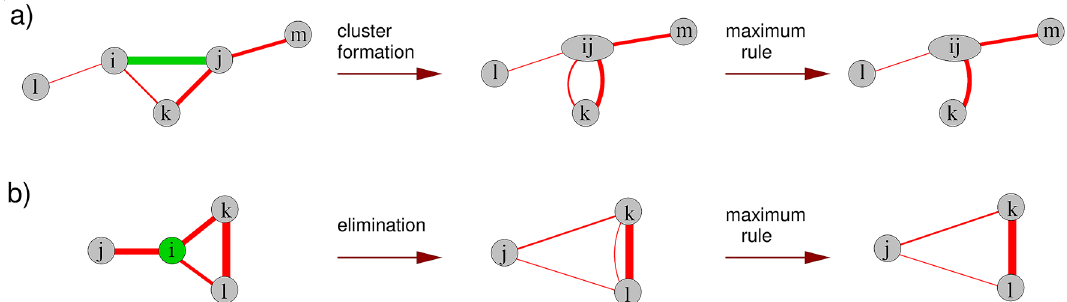
Figure 2. Illustration of the SDRG method. Two types of reduction steps of the SDRG procedure: formation of a cluster ( a ) and elimination of a site ( b ). The thickness of lines indicates the magnitude of the infection rate on the corresponding link. The link ( a ) and the site ( b ) to be decimated is shaded in green. For details, see the